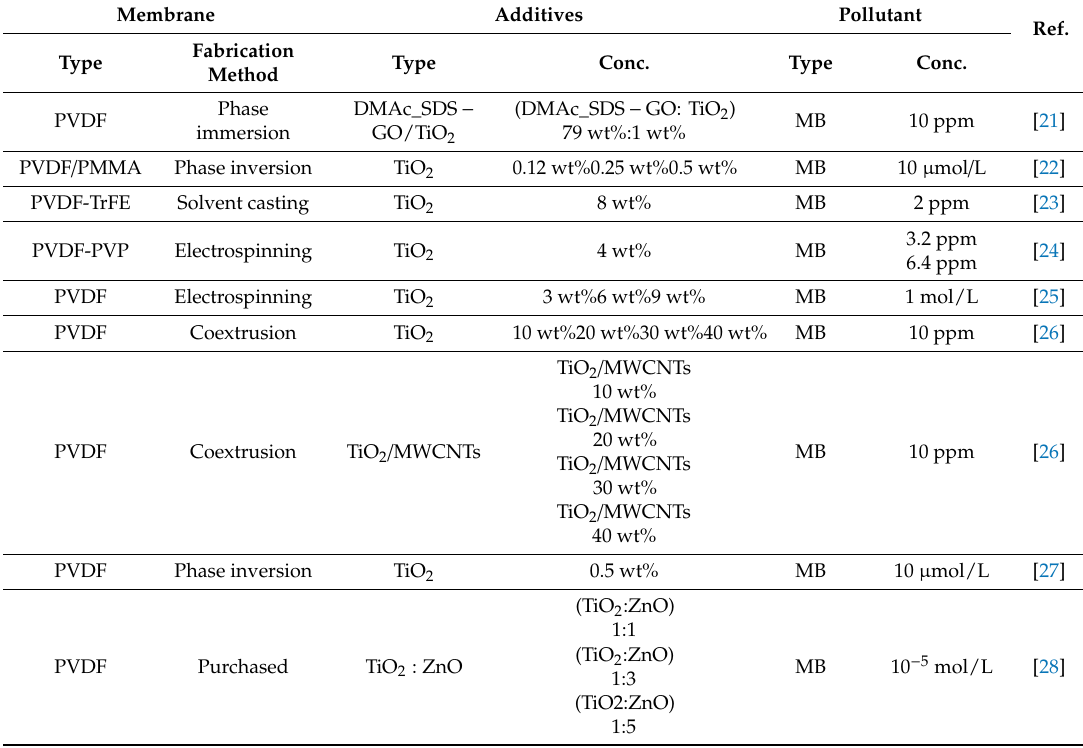
Table 1. Summary of previous studies utilizing polyvinylidene fluoride (PVDF)-titanium dioxide (TiO 2 ) photocatalytic membrane reactors